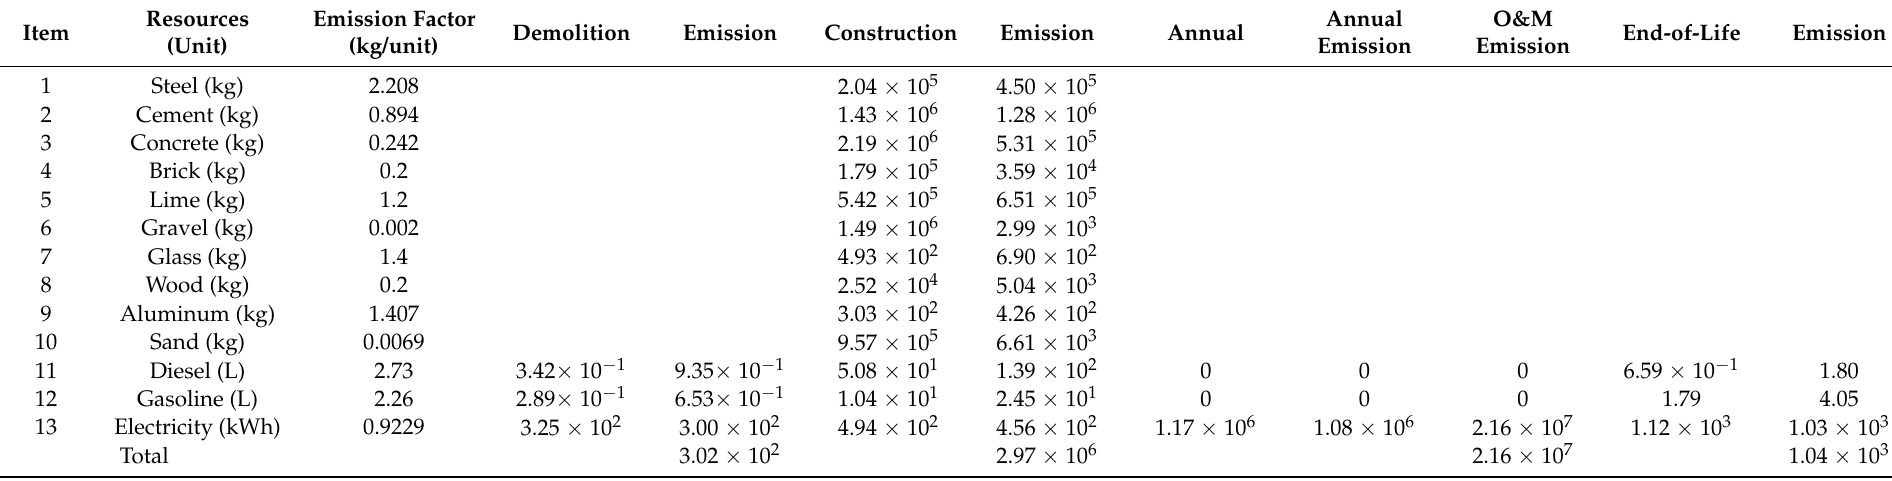
Table 7. CO 2 emissions in the refurbishment